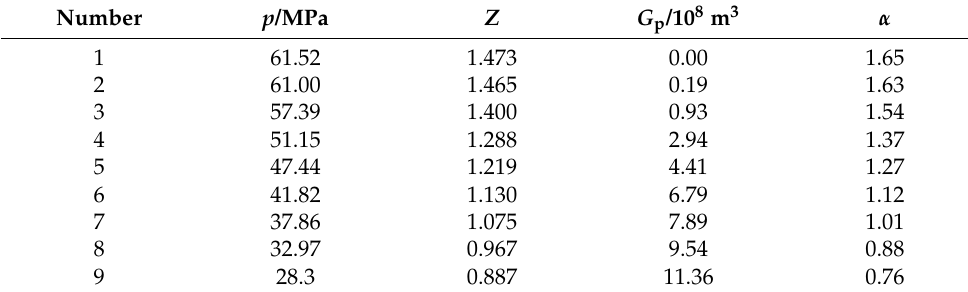
Table A1. Historical production data of the N. Ossun reservoir [33].